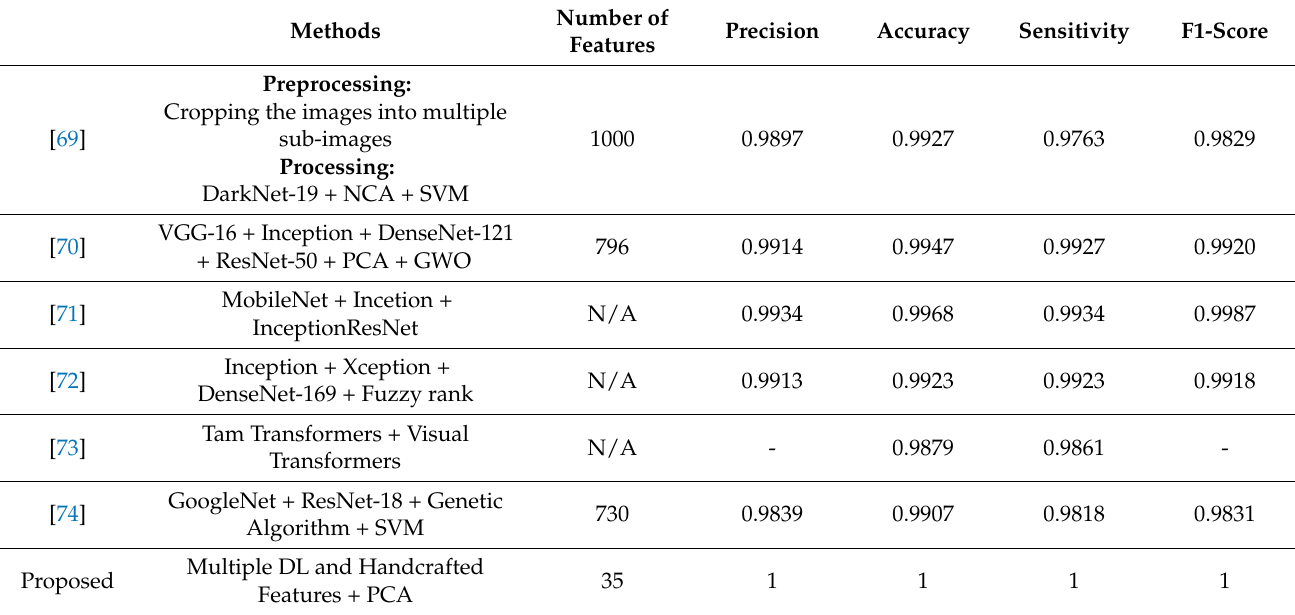
Table 5. Comparative analysis between state-of-the-art methods and the introduced CAD constructed with the Mendeley LBC